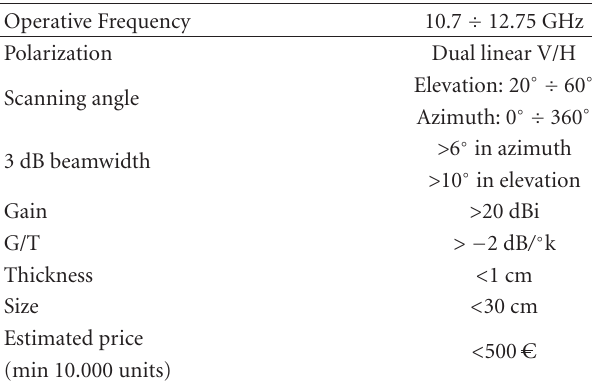
Table 2: Expected antenna